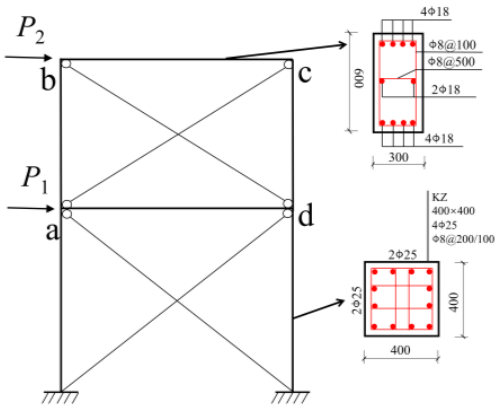
Figure 7. Sketch of model calculation.